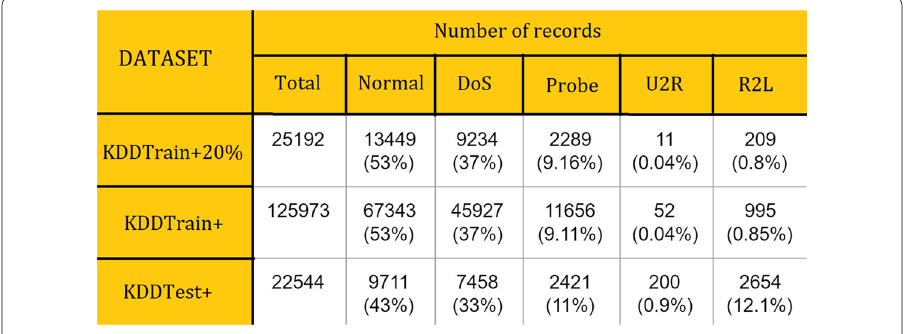
Fig. 4 Number of instances for all the